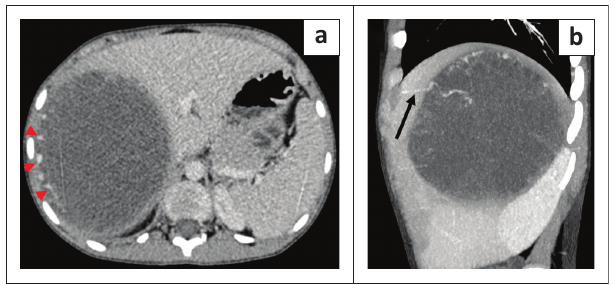
FIGURE 2: (a) Axial contrast-enhanced CT images demonstrating the cystic appearance of the mass with eccentric internal vascularity (red arrow heads); (b) Sagittal maximum intensity projection image showing a tortuous artery supplying the periphery of the lesion as denoted by the black arrow.